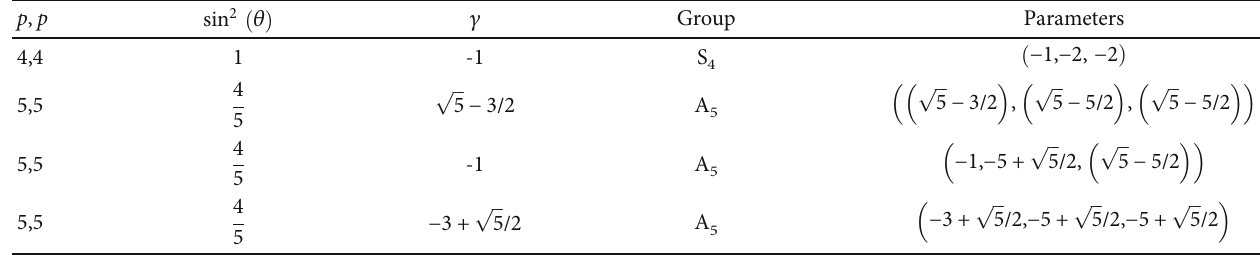
Table 3: Principal Characters: 4,4 and